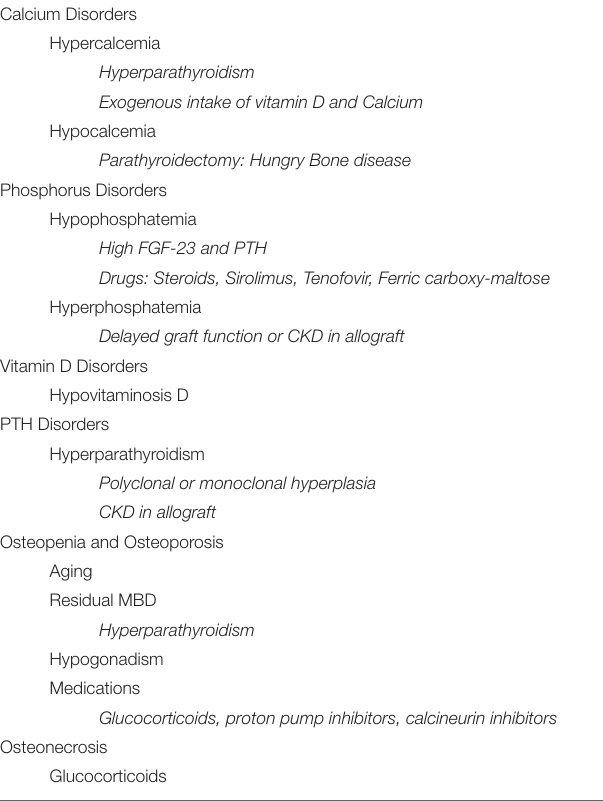
TABLE 1 | Mineral and bone disorders after kidney